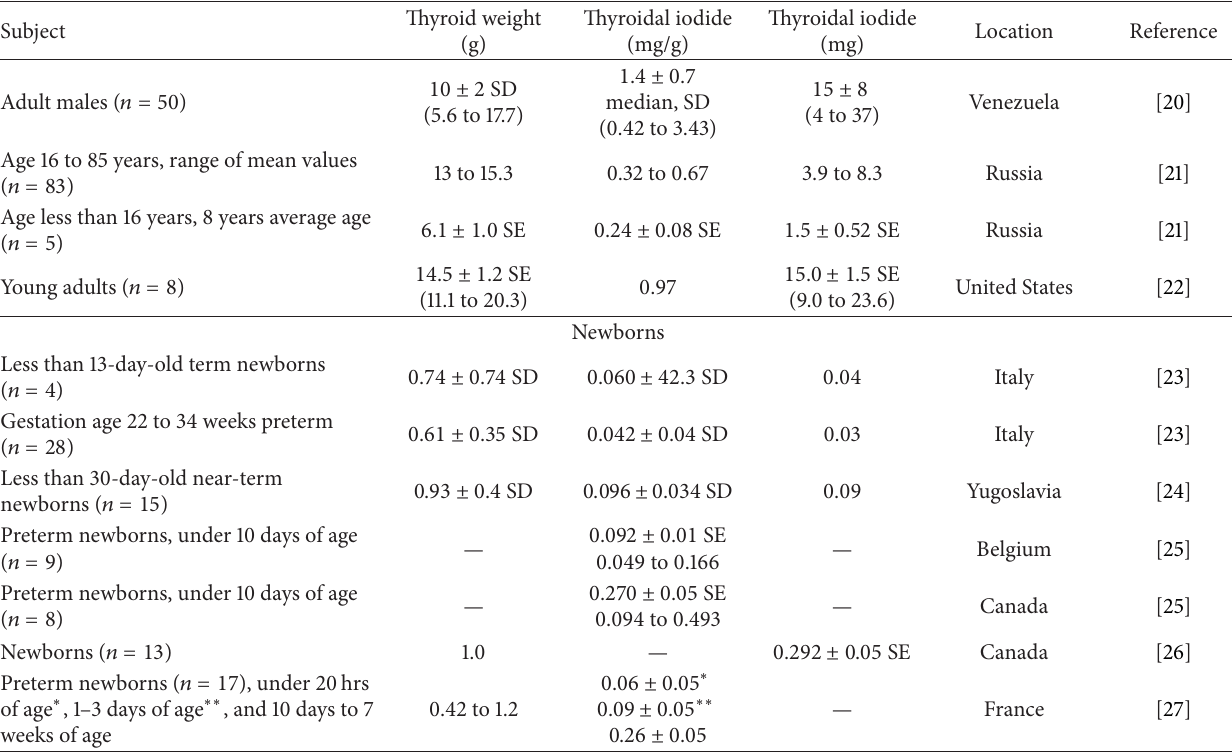
Table 3: Thyroid gland weights and thyroidal iodide stores in infants, children, and adults.